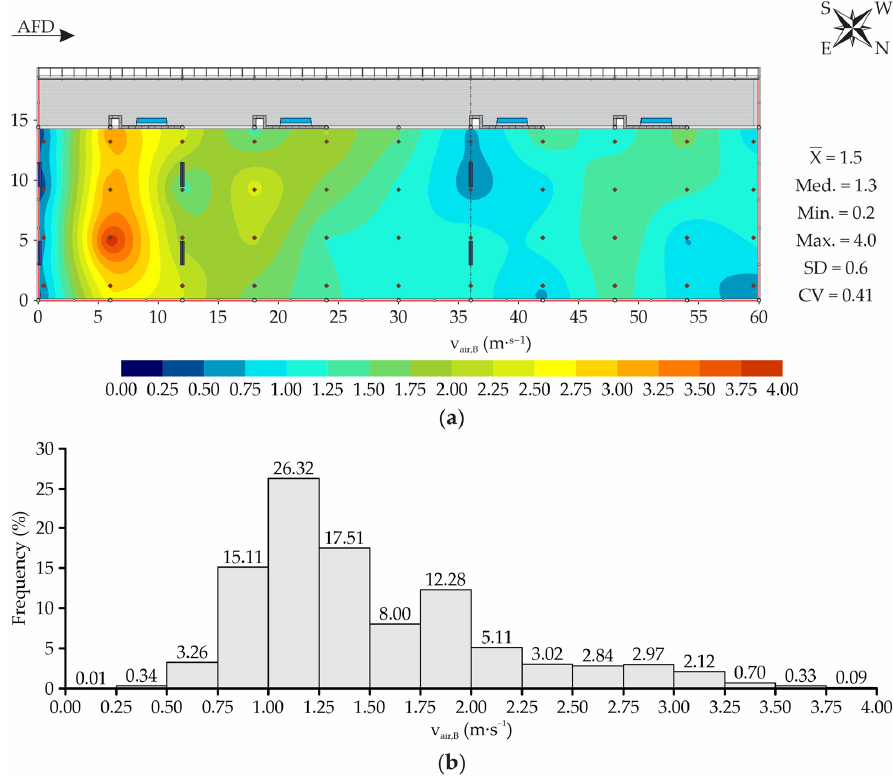
Figure 9. Spatial ( a ) and frequency ( b ) distribution of air velocity at bedding level (v air,B ). AFD—air-flow direction; 𝑋(cid:3364) —mean; Med.—median; Min.—minimum; Max.—maximum; SD—standard deviation; CV— coefficient of variation.